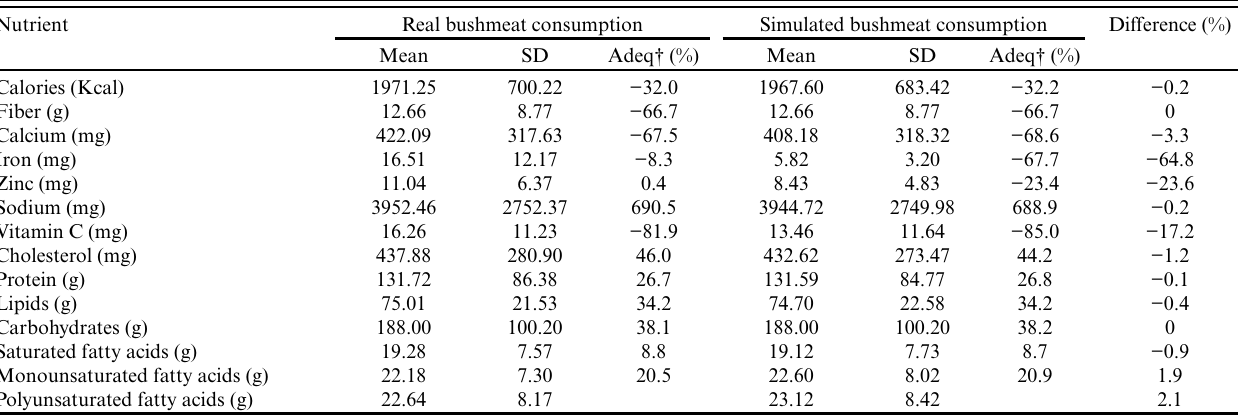
Table 6. Results of sensitivity analysis performed on nutrient intake per adult equivalent per day for the substitution of bushmeat by chicken.